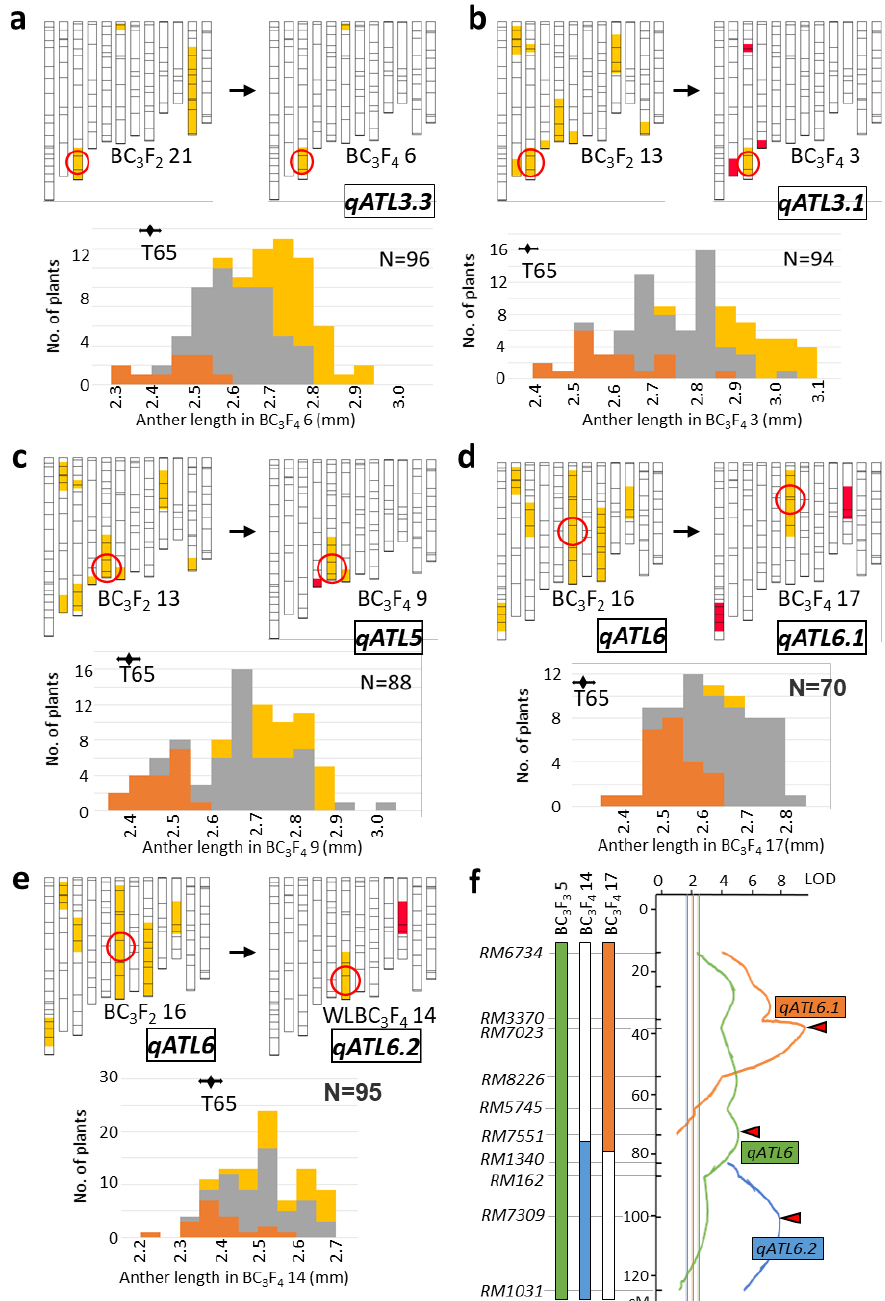
Figure 4. Validation of the anther length quantitative trait locus (QTLs) located on chromosomes 3, 5, and 6 in BC 3 F 4 populations segregating at only one QTL region. ( a )–( e ) Graphical genotypes of the parents of BC 3 F 3 and BC 3 F 4 populations, and frequency distributions of anther length in BC 3 F 4 populations for ( a ) qATL3.3 , ( b ) qATL3.1 , ( c ) qATL5 , ( d ) qATL6.1 , and ( e ) qATL6.2 . Graphical genotypes: Yellow, heterozygous; red, homozygous for the W1508 allele. Frequency distributions shown in colors by genotypes at RM5959 ( a ), RM3525 ( b ), RM1054 ( c ), RM7023 ( d ), and RM7309 ( e ): Orange, homozygous for T65; yellow, homozygous for W1508; gray, heterozygous; ( f ) logarithm of odds (LOD) curves in simple interval mapping of anther length for detection of qATL6 (green) in BC 3 F 3 5, qATL6.1 (orange) in BC 3 F 4 17, and qATL6.2 (blue) in BC 3 F 4 14. Among the 71 plants in the BC 3 F 2 13 population, the range of anther length was 2.26 – 3.32 mm, with a population mean of 2.82 mm. Simple interval mapping revealed two QTL: qATL3.1 at 137.6 cM on Chr. 3, and qATL5 at 122 cM on Chr. 5. Segregation distortion at qATL5 was detected at the